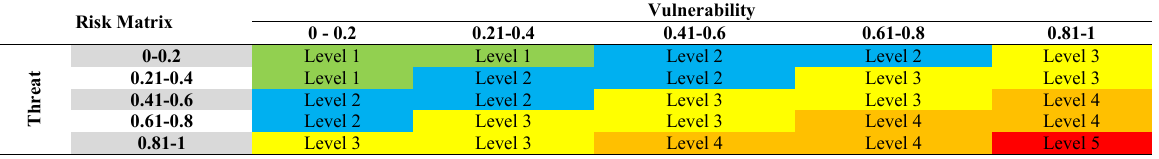
Risk Matrix Level (Chien et al., 2019)